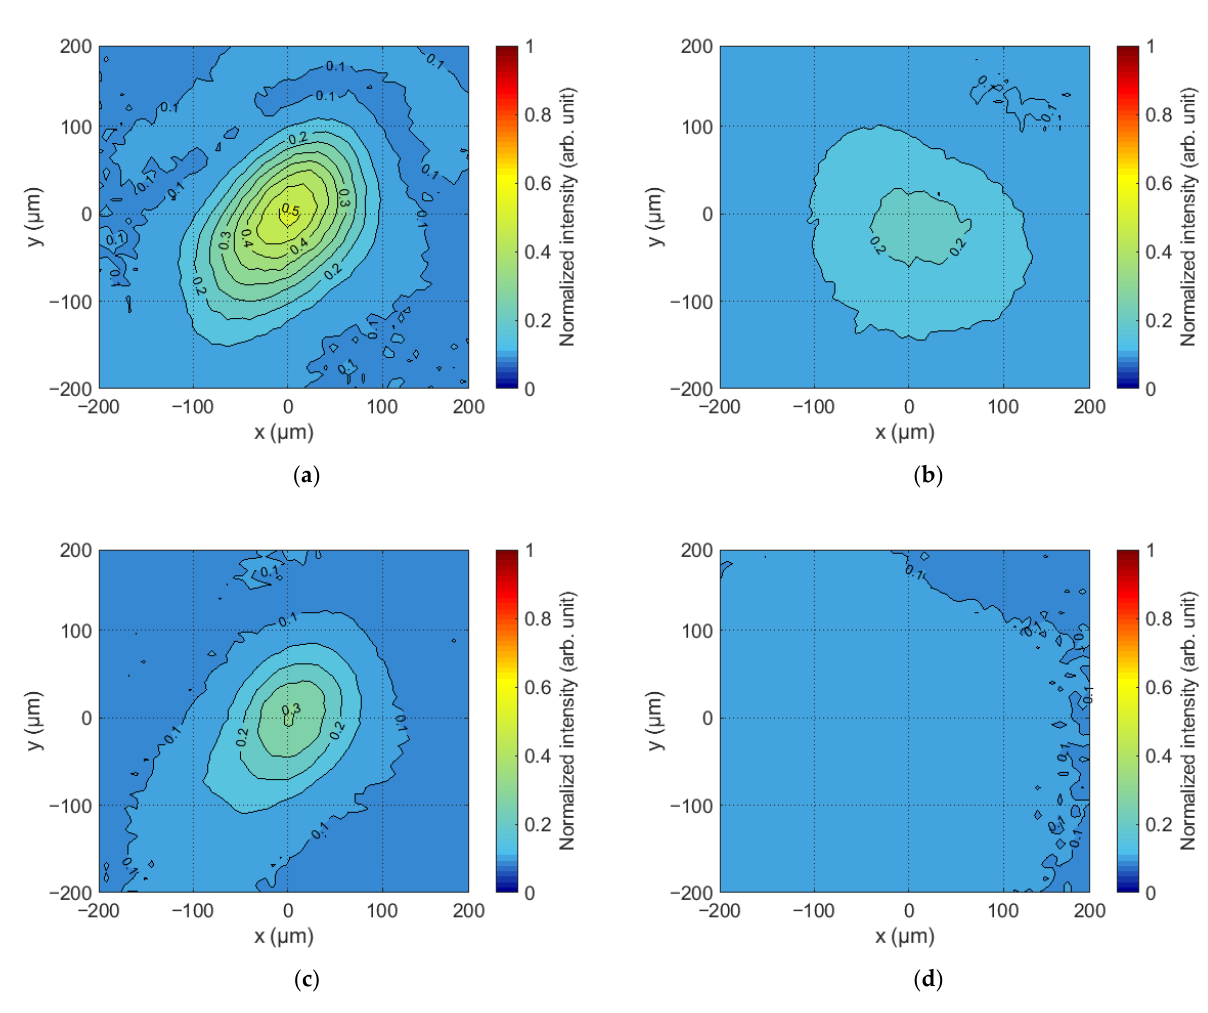
Figure 5. Correlation response in the output to the SLM of the grayscale and binary Fourier CGH with the value of the weight coefficient of the Zernike polynomial: ( a ) 0.53λ for grayscale Fourier with the value of the weight coefficient of the Zernike polynomial: ( a ) 0.53 λ for grayscale Fourier CGHs; ( b ) 1.33λ for grayscale Fourier CGHs; ( c ) 0.53λ for binary Fourier CGHs; ( d ) 1.33λ for binary CGHs; ( b ) 1.33 λ for grayscale Fourier CGHs; ( c ) 0.53 λ for binary Fourier CGHs; ( d ) 1.33 λ for binary Fourier CGHs. Fourier CGHs.